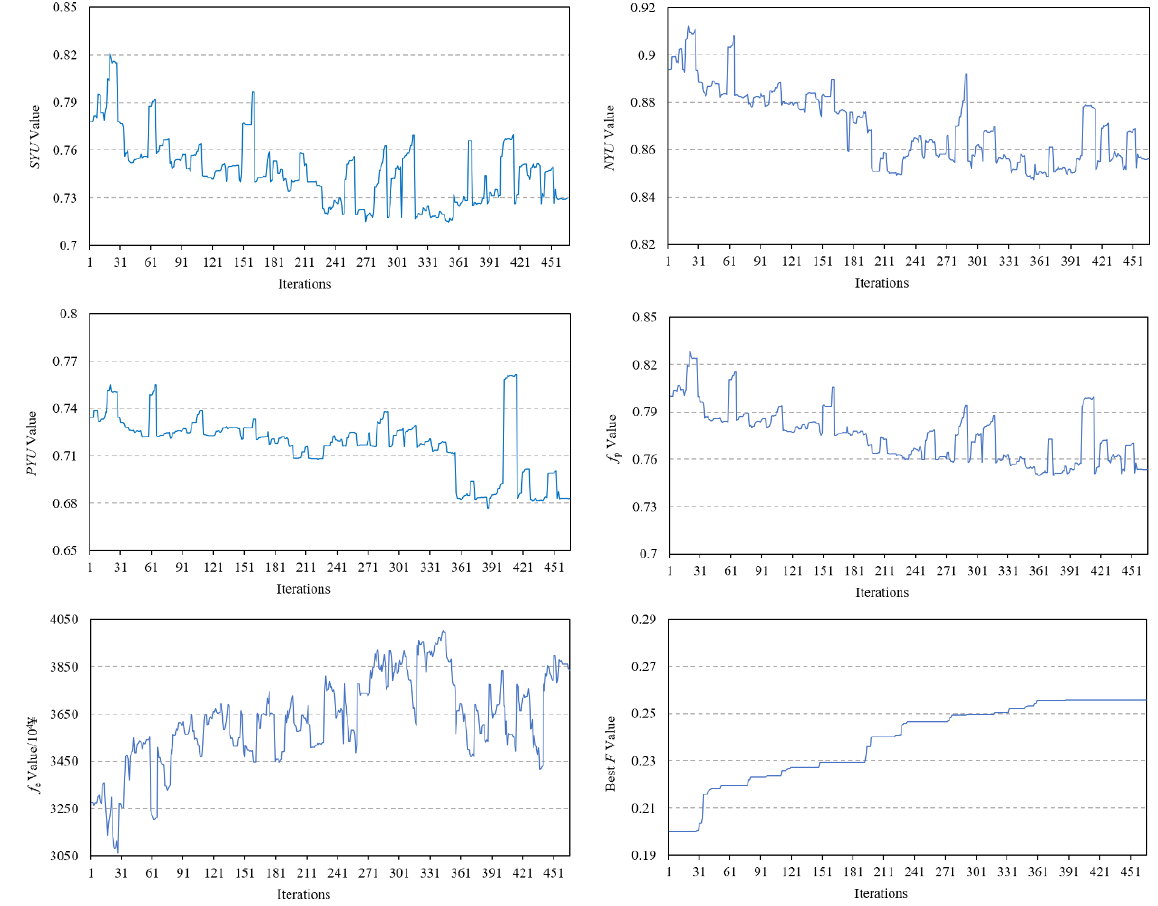
Figure 4. The value of each objective function changed with the MTSA iteration. After 318 iterations, f p began to move near the optimal value and no longer decreased, and the trends of SYU, NYU, and PYU were similar to f p . This revealed that with the iter-